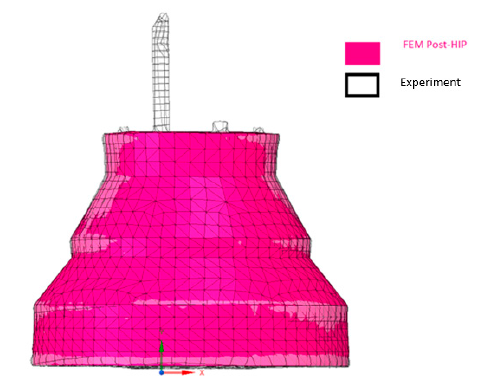
Figure 17. Post ‐ HIP FEM model geometry overlayed with the post ‐ HIP physical experimental geometry. Table 3. Final dimensions.